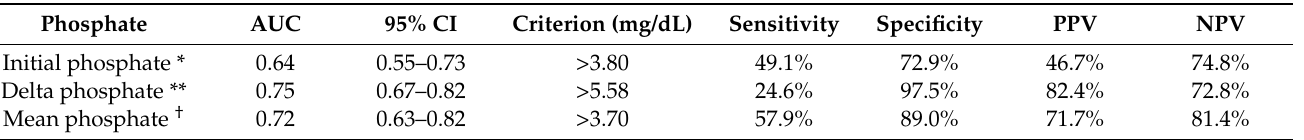
Table 4. Hospital mortality predictions according to phosphate metric categories calculated by a receiver operating characteristic curve.